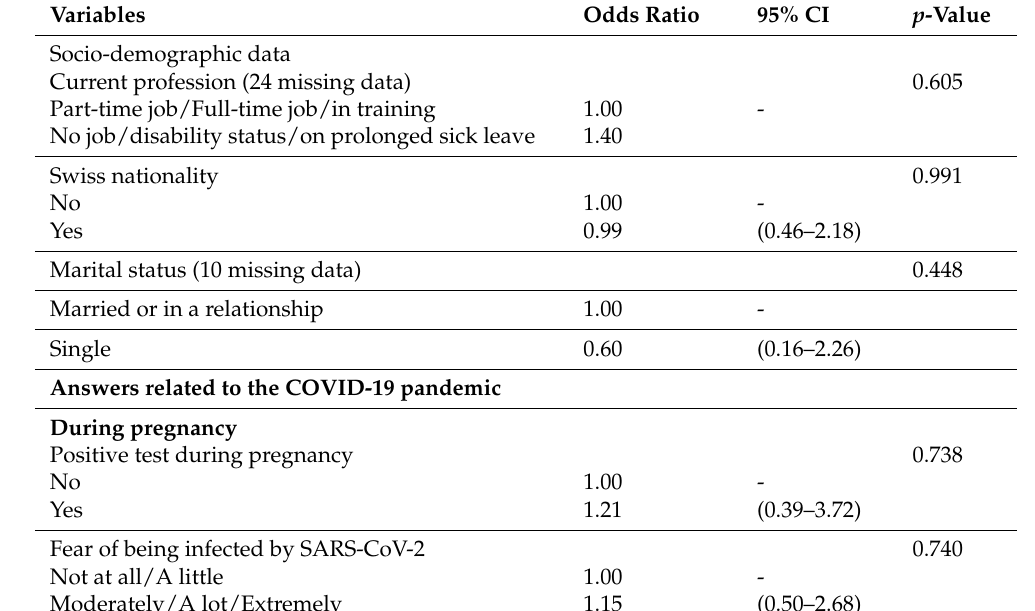
Table 13. Variables associated with breastfeeding (measures of associations, univariate